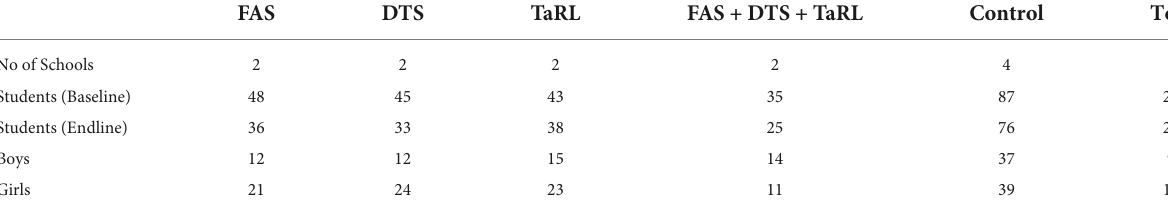
TABLE 4 Sample descriptives.